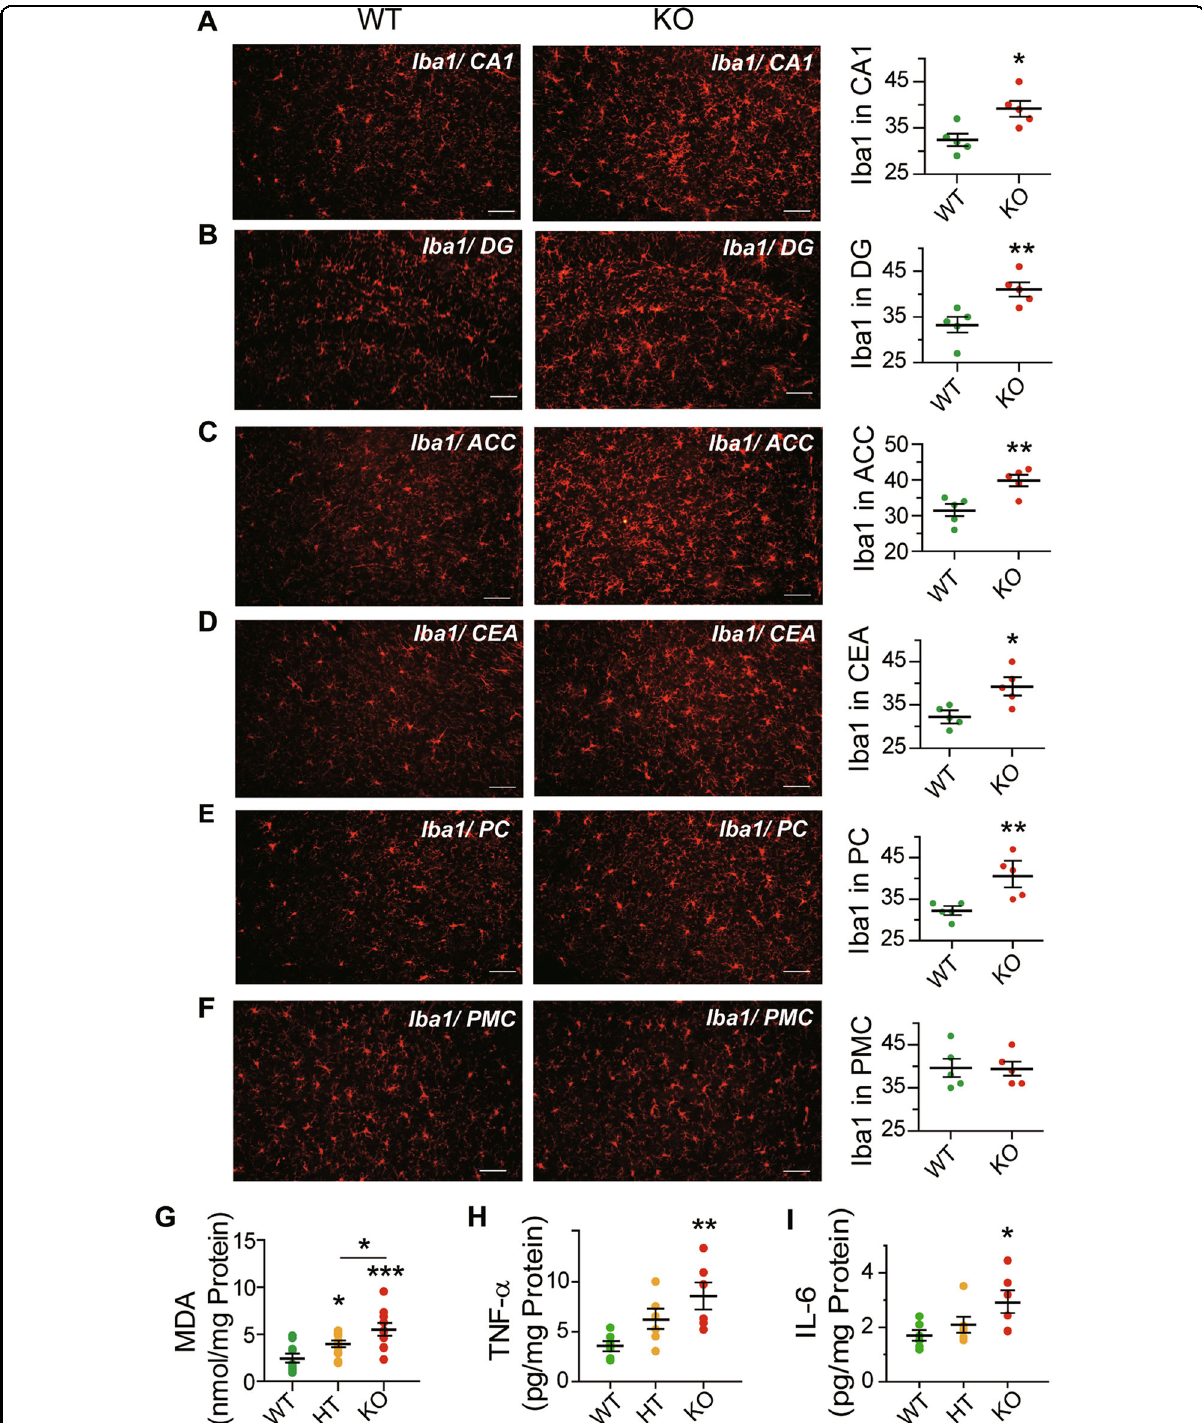
Fig. 5 Neuroin fl ammation in Gabrb2 KO mice. Coronal sections were stained through fl uorescence-labeling of Iba1 on microglia in: a CA1 of hippocampus; b dentate gyrus (DG); c anterior cingulate cortex (ACC); d central amygdaloid nucleus (CEA); e piriform cortex (PC); and f primary motor cortex (PMC). In (a – f) , the number of Iba1-positive cells in WT or KO was estimated from fi ve randomly selected images for each of fi ve WT or KO males. Brain levels of g MDA (WT male n = 10, HT male n = 12, KO male n = 10), h TNF- α (WT, HT, and KO males, n = 6 in each group) and i IL-6 (WT, HT, and KO males, n = 6 in each group) were measured and expressed per mg protein of sample analyzed. Statistical analysis was performed using unpaired t -test for immunohistochemical measurements and one-way ANOVA with Newman – Keuls post-hoc test for the biochemical measurements; WT is represented by green dots, HT by orange dots, and KO by red dots. Average y values ± SEM in the different plots are represented by horizontal bars; * p < 0.05, ** p < 0.01, *** p <